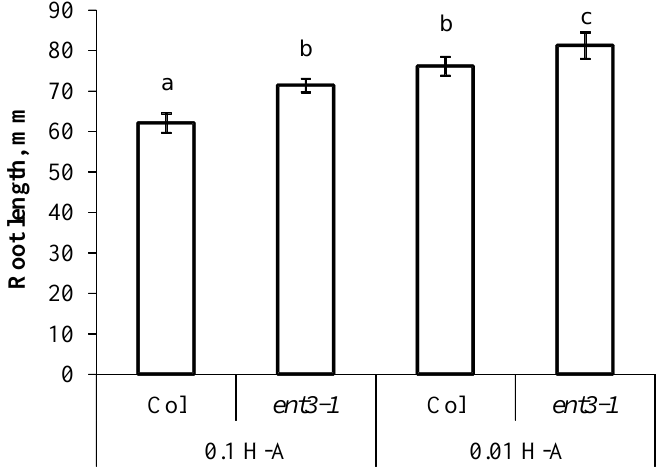
Figure 5. The length of the primary root of 5 weeks old ent3-1 Arabidopsis mutant and its parent ecotype Columbia (Col) 7 day after dilution (0.01 H-A) of optimal 0.1 strength Hoagland–Arnon nutrient solution (0.1 H-A). Statistically differing means (n = 20) are indicated with different letters ( p < 0.05, Students t -test).